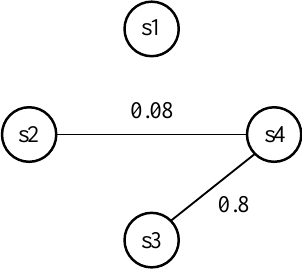
Figure 5. The conflict graph of the illustrative example. There are overlapping links between 𝑠 2 and 𝑠 4 , 𝑠 3 and 𝑠 4 .